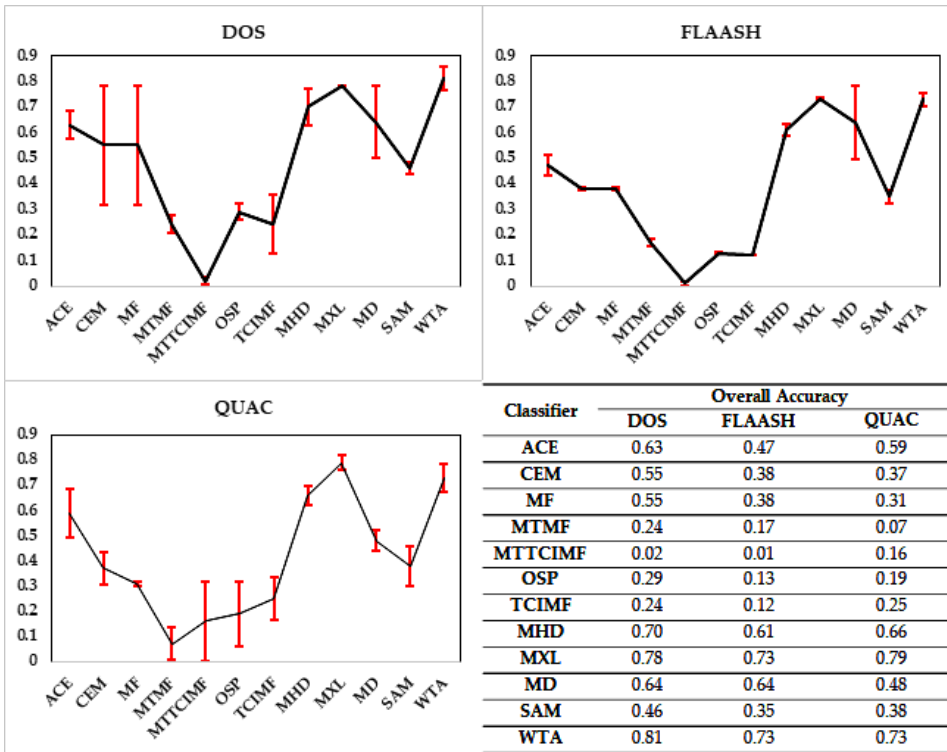
Figure 6. Overall accuracy depicted as a line graph and calculated variances as error bars across all classification algorithms for each atmospheric correction. Bottom-right inset table shows the values of overall accuracy for each of the correction methods.